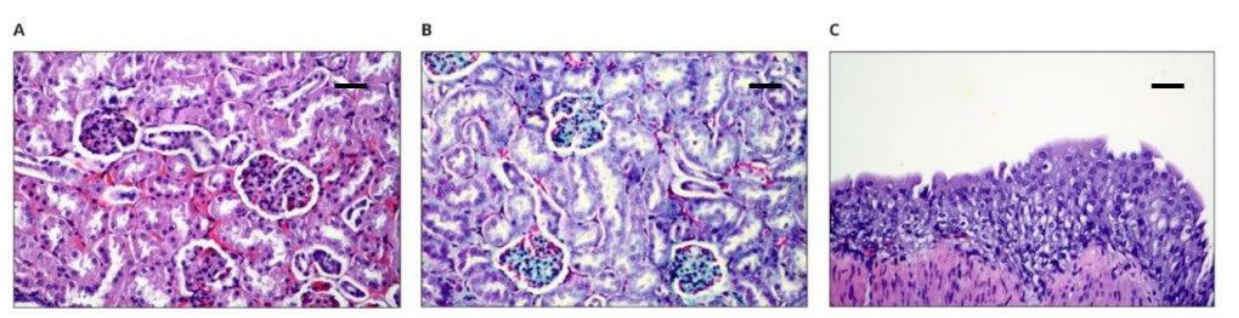
Figure 6. Microscopically assessed image of lungs collected from animals with implants: ( A ) 100×